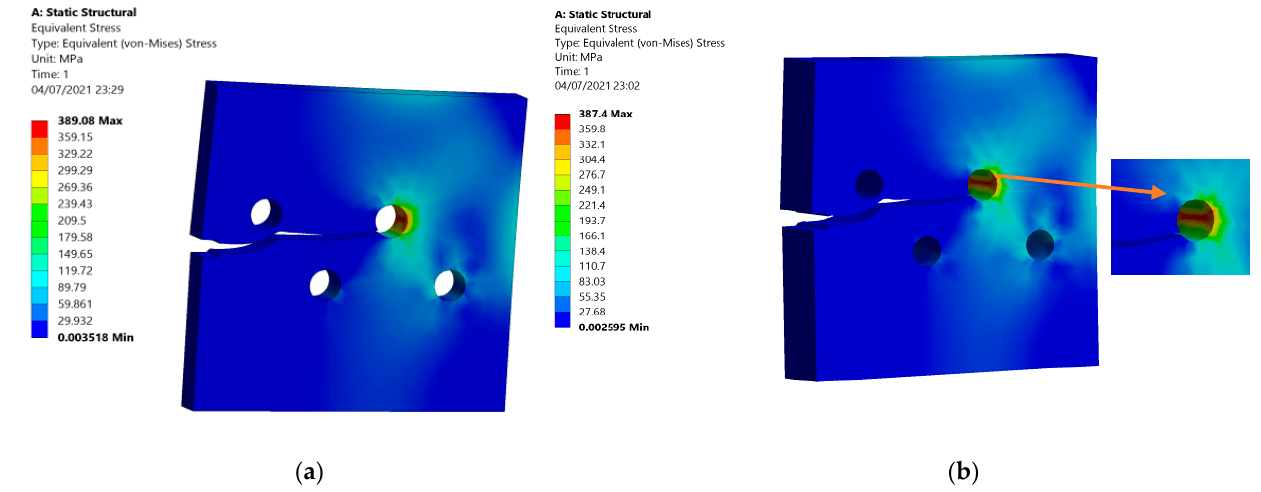
Figure 5. Von Mises stress distribution: ( a ) 10 mm thickness, ( b ) 20 mm thickness.